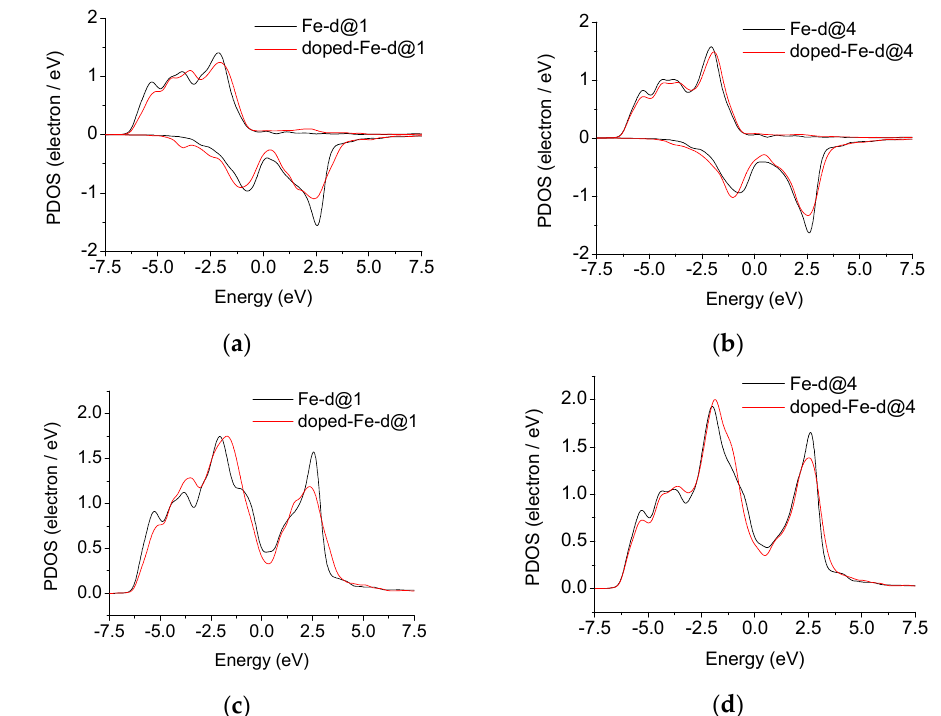
Figure 7. Nb-undoped and Nb-doped electronic density of states of bcc Fe for Σ 3[110] (112) grain boundaries; contributions from spin-up and spin-down eigenstates at ( a )position 1, ( b ) position 4; contributions from both spin-up and spin-down eigenstates summed at ( c ) position 1, ( d ) position 4.